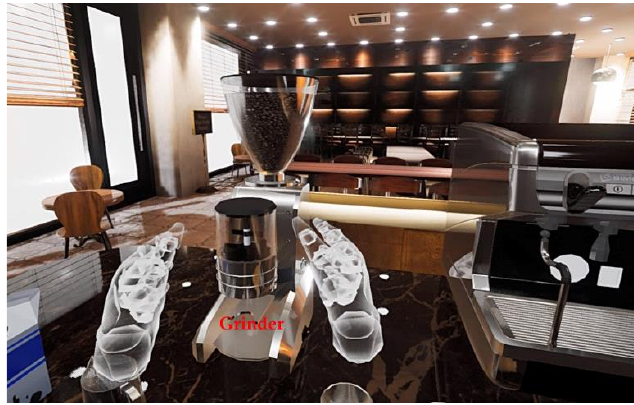
Figure 4. A screenshot of the terminology education.